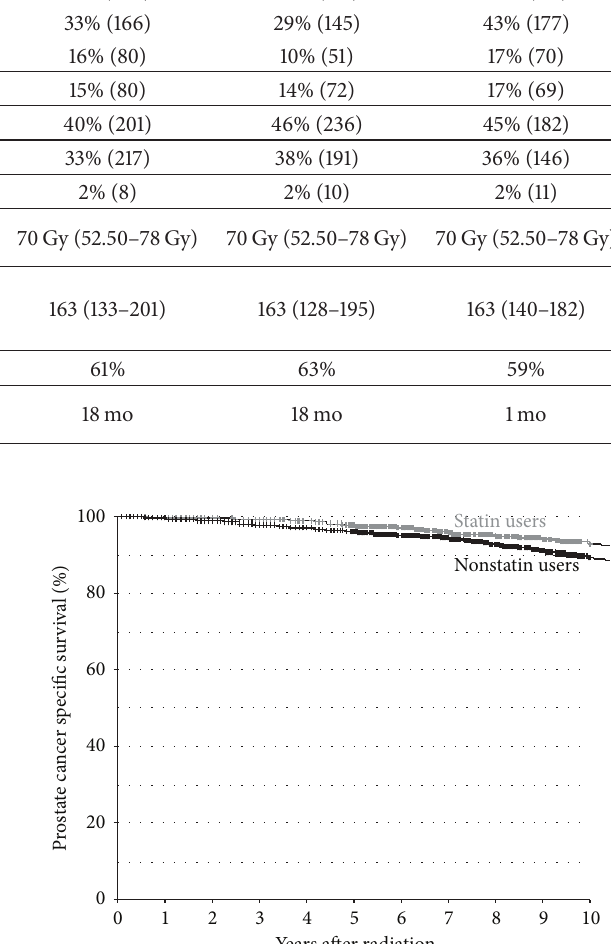
Figure 1: Prostate cancer specific survival between statin users and